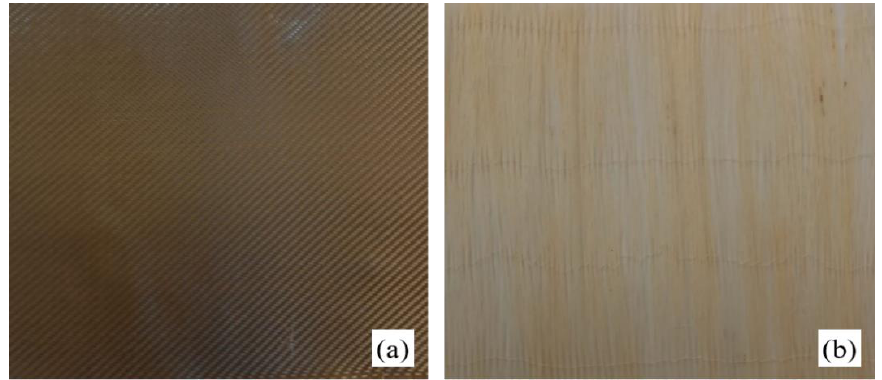
Figure 1. ( a ) Twill-type commercial basalt fabrics and, ( b ) unidirectional sisal-stitched fabrics properly made in the laboratory.